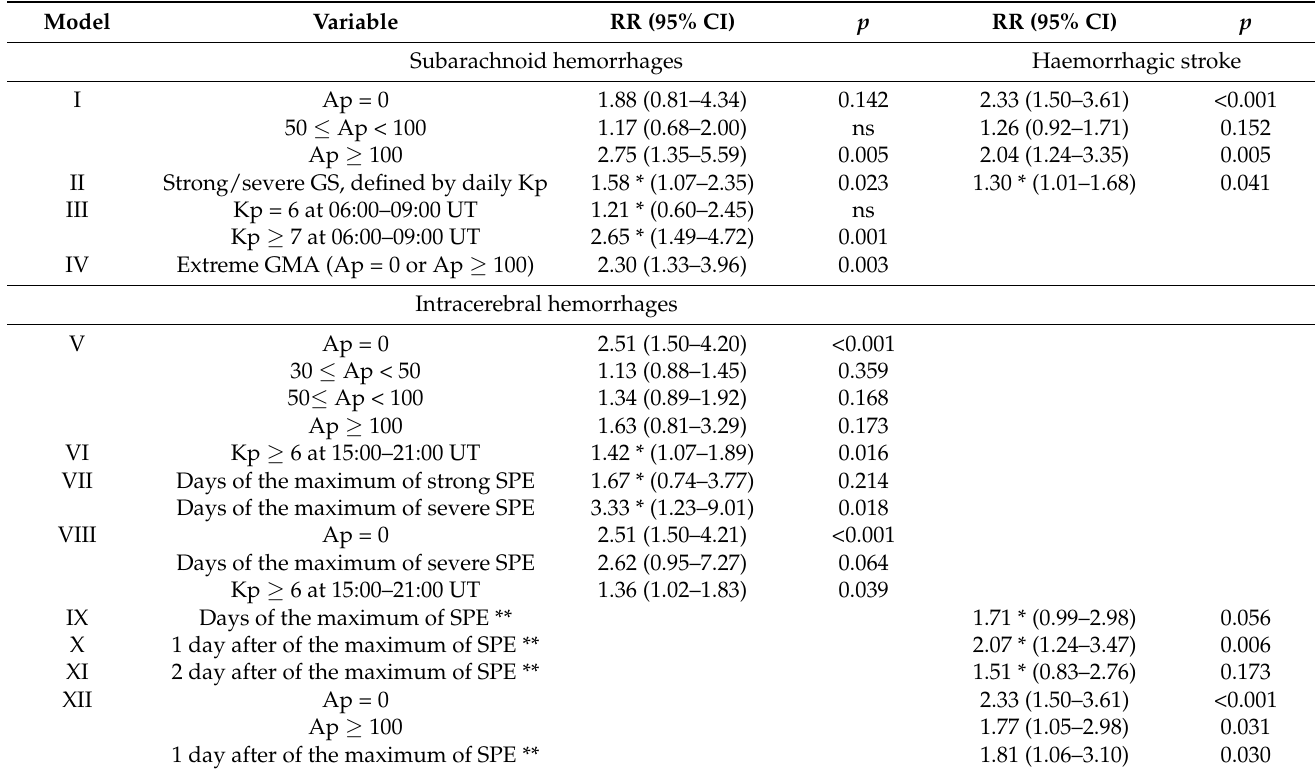
Table 3. Rate Ratios (cid:7) , 95% Confidence Intervals (CI), and p -values for the associations between the occurrence of haemorrhagic stroke and space weather variables in a time-stratified multivariate model.